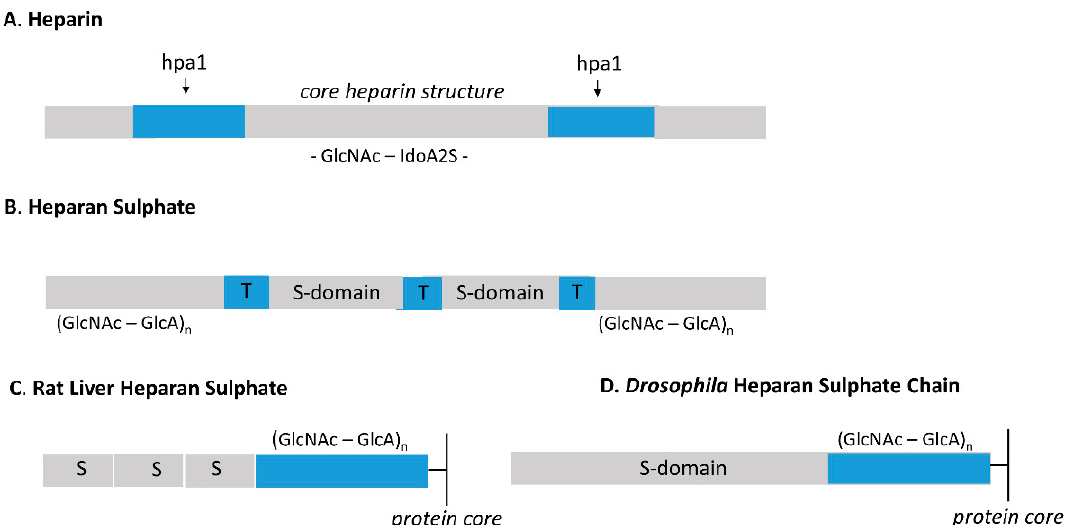
Figure 2. Differences in molecular design between characteristic regions of heparin ( A ) and heparan sulphate ( B ). The structure of the highly sulphated heparin is dominated by the trisulphated GlcNS6S—IdoA2S unit; however, there are less sulphated sequences that can be cleaved by an endoheparanase, hpa1, distributed throughout the chain at approximately 15 kDa intervals. The molecular design of HS is quite distinct from that of heparin. The sulphated regions composed of S- and NA/NS-domains (or T-zones) are arranged in a regular manner along the glycosaminoglycan (GAG) chain separated by extensive areas that lack any enzymatic modification (NA domains). A long NA sequence of nine to 10 disaccharides is present in the inner region of HS proximal to the protein core (shown in ( C , D )), depicting, respectively, the asymmetric rat liver HS and the two-domain Drosophila HS). A comparable sequence is not present in heparin. The “composite regions” of sulphation in HS illustrated above are ~ 7 kDa in size and can be excised by K5- heparan lyase that acts specifically on NA sequences. This enzyme is inhibited by the presence of the N -sulphate group. Hpa1